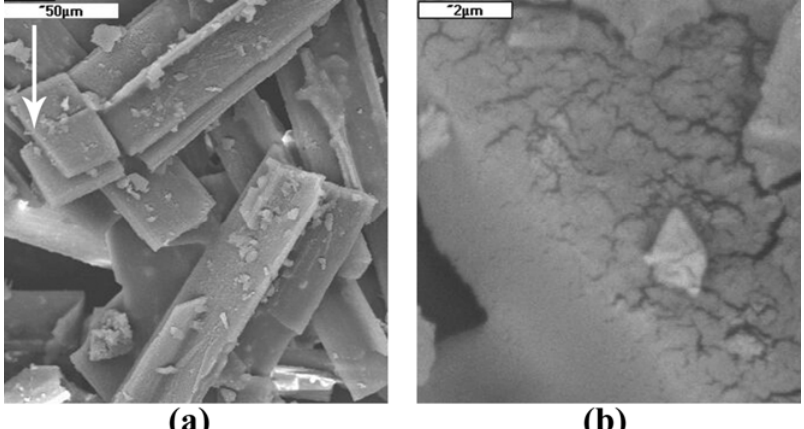
Figure 3. SEM micrographs of ZnTBPP crystals. ( a ) ×500; ( b ) ×10,000 (enlargement of arrow-pointed